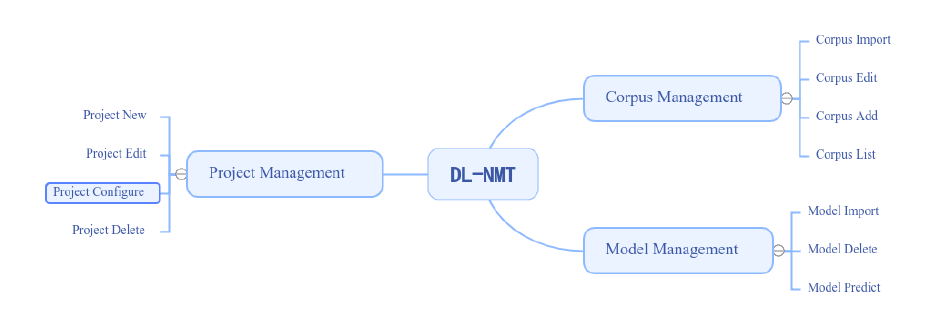
Figure 6. The DL-NMT web interface